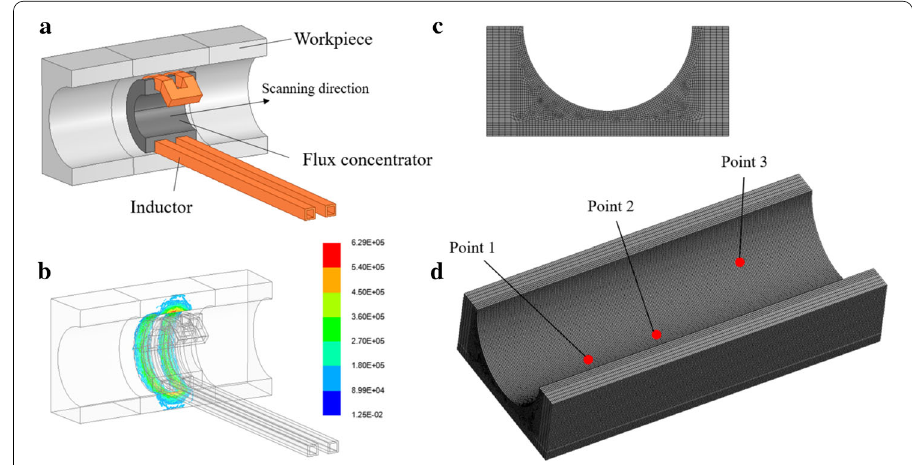
Fig. 12 Objects of study ( a ), generated magnetic field ( b ) and FE mesh (cross-section in c and full body in c ), composed of 624k linear hexagonal and triangular elements, for the semi-analytic simulation. Points of study marked in red ( d )